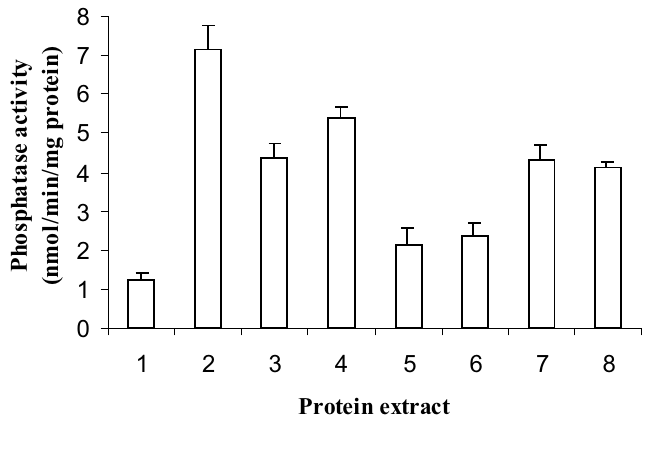
Fig. 3 – Spectrophotometric measurements of phosphatase activity in protein extracts from YHH-33 yeast cells transformed with constructs coding for different hybrid proteins of the spinach sucrose transporter, KST1, and acid phosphatase. Protein extract from 2 came from cells containing vector 181A1NE-STSS-PHO5 and showed maximum acid phosphatase activity. Hybrid proteins from extracts 3 and 5 were designed to position PHO5 outside the cell, between subdomains 1-2 and 3-4 of the six-membrane spanning domains of protein KST1, respectively. Hybrid proteins from extracts 4 and 6 were designed to position PHO5 facing the cytosol between subdomain 2-3 and 4-5 of KST1, respectively. Extract 7 harbours the hybrid protein coded by the sequence containing pho5 in frame to the first 260 bp of KST1 thought to possess the signal sequence, while extract 8 codes for PHO5 facing the cell exterior linked to the first intermembrane domain of the spinach sucrose transporter. Protein extract from 1 was obtained fromYHH-33 cells transformed with yeast vector 181A1NE only and represents the background acid phosphatase activity (PHO3, PHO10, constitutively expressed at a very low concentration). Assays were done with three different colonies from each